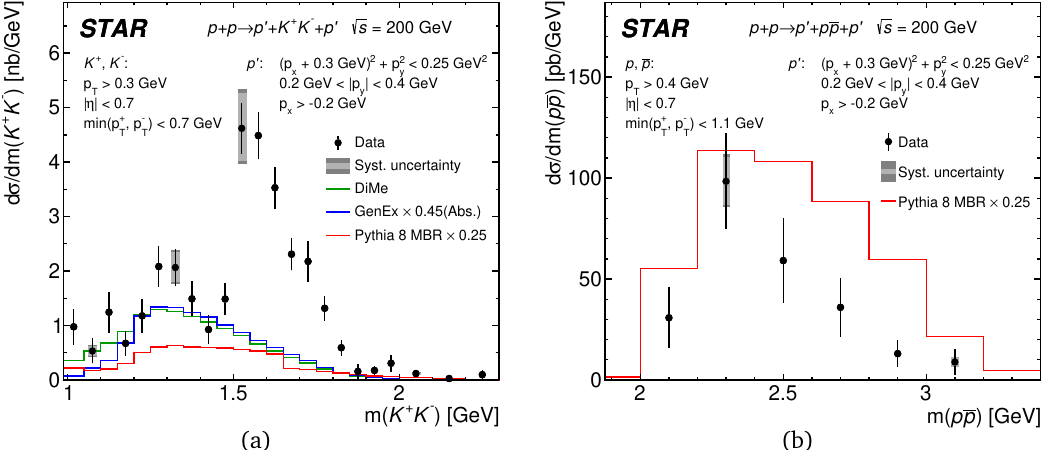
Figure 3: Differential cross sections for CEP of (a) K + K − and (b) p ¯ p pairs as a func- tion of the invariant mass of the pair, measured in the fiducial region explained on the plots [ 5 ] . Data are shown as solid points with error bars representing the sta- tistical uncertainties. The typical systematic uncertainties are shown as grey boxes for only a few data points as they are almost fully correlated between neighbouring bins. Predictions from Monte Carlo models GenEx, DiMe and MBR are shown as